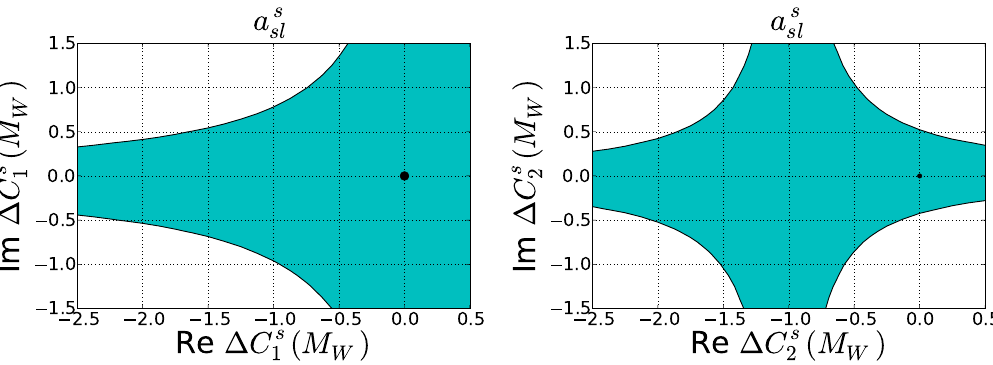
Figure 16 . Potential regions for the NP contributions in (cid:1) C s semileptonic asymmetry a s at 90% C.L. . The black point corresponds to the SM value. For the pur- sl poses of illustration we have made the universality assumptions: (cid:1) C s;uu